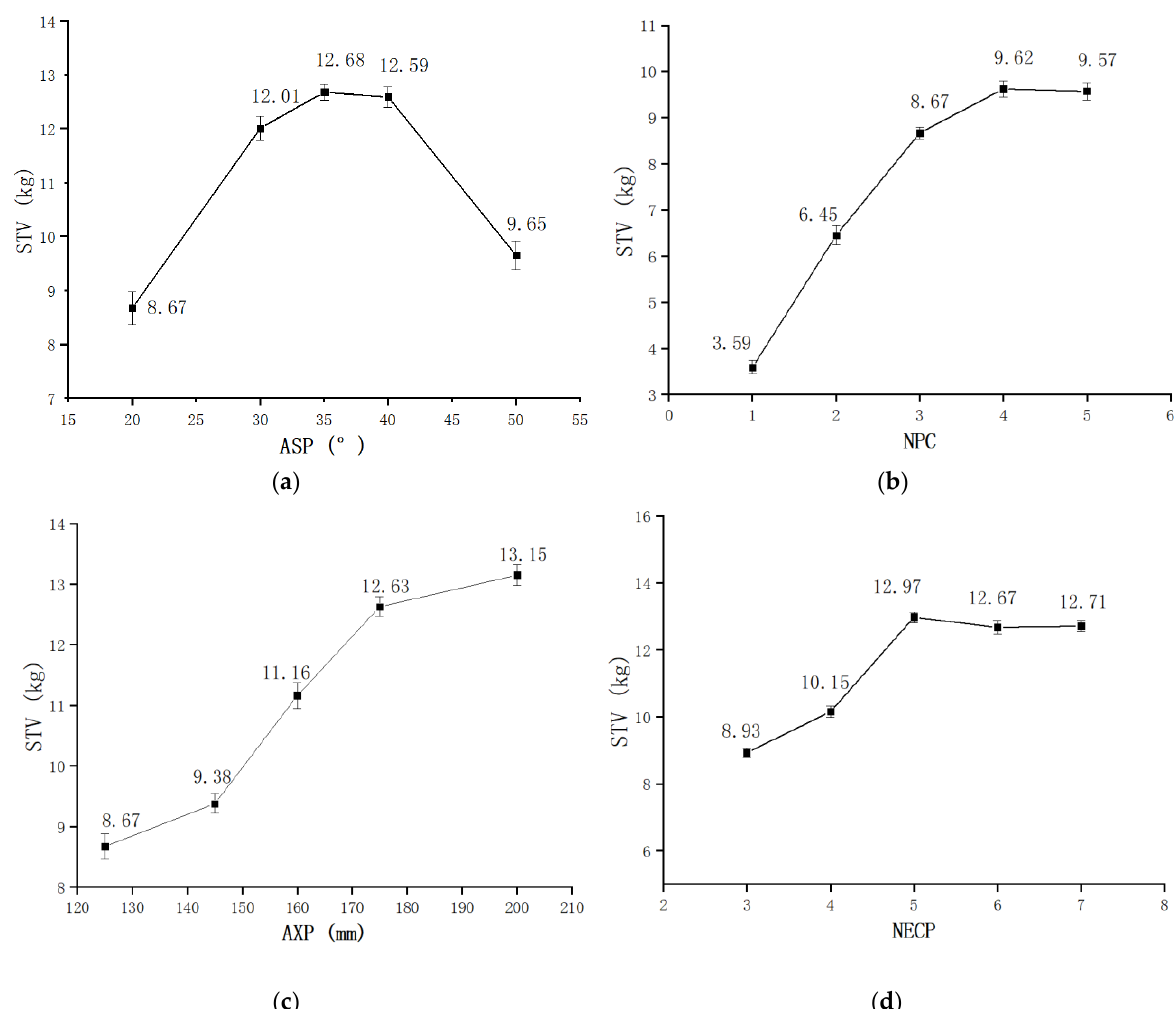
Figure 6. ( a ) Influence of ASP on STV. ( b ) Influence of NPC on STV. ( c ) Influence of AXP on STV. ( d ) Influence of NECP on STV